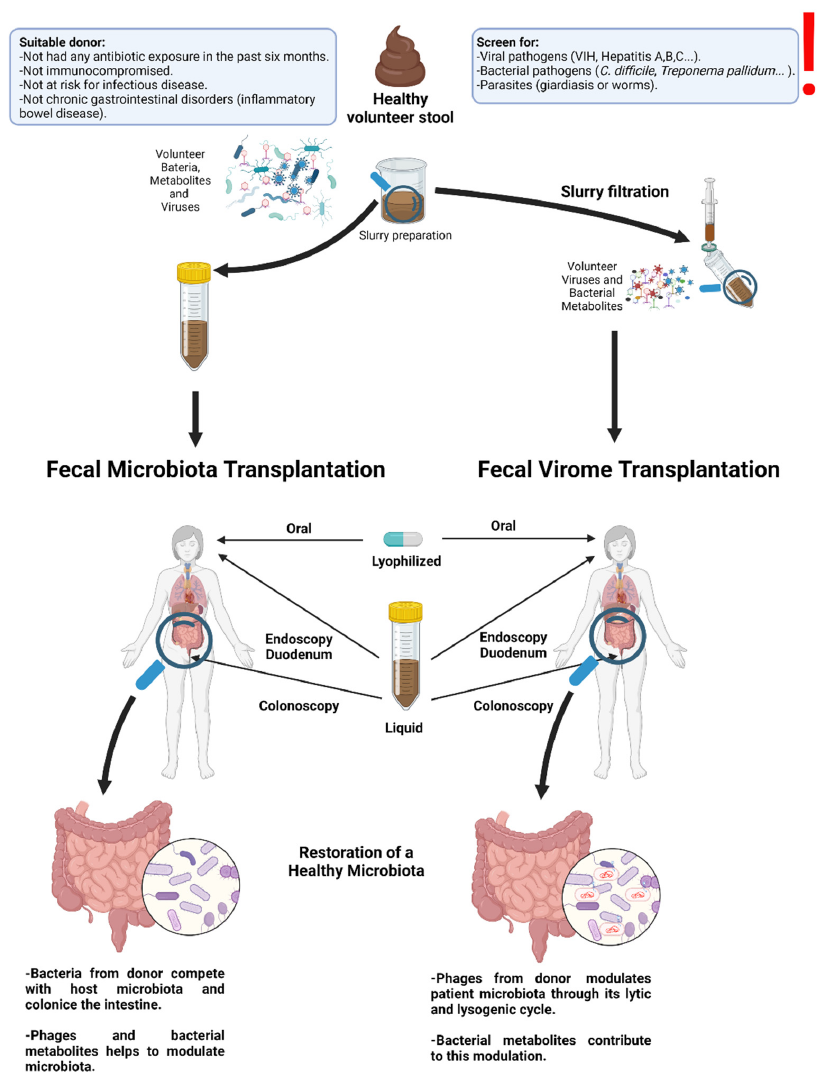
Figure 2. Representation of microbiota and virome transplantation in humans. The first step in this process is the selection of healthy volunteers and the creation of biobanks with stool samples. Vol ‐ unteers must meet several requirements and have pathogen ‐ free stool to avoid disease transmission to the transplant recipient. Two different strategies have been developed when performing fecal transplants. In fecal microbiota transplantation (FMT), no microorganisms are removed from the samples, whereas in fecal virome transplantation (FVT), the feces are filtered to eliminate the bacte ‐ ria, molds, and yeasts present in the donor’s samples and to keep only the viruses, primarily bacte ‐ riophages, present in the fecal samples. Fecal transplants can be administered in a variety of ways, for example, through gastroscopy or colonoscopy. Stool samples can also be lyophilized, and there ‐ fore, these transplants can be performed orally, through the administration of a tablet, or through the anal route in the form of a suppository. rial infections [5]. Currently, there is evidence that phages can stimulate and modulate the immune system of the host by various mechanisms. Indeed, phages can colonize the